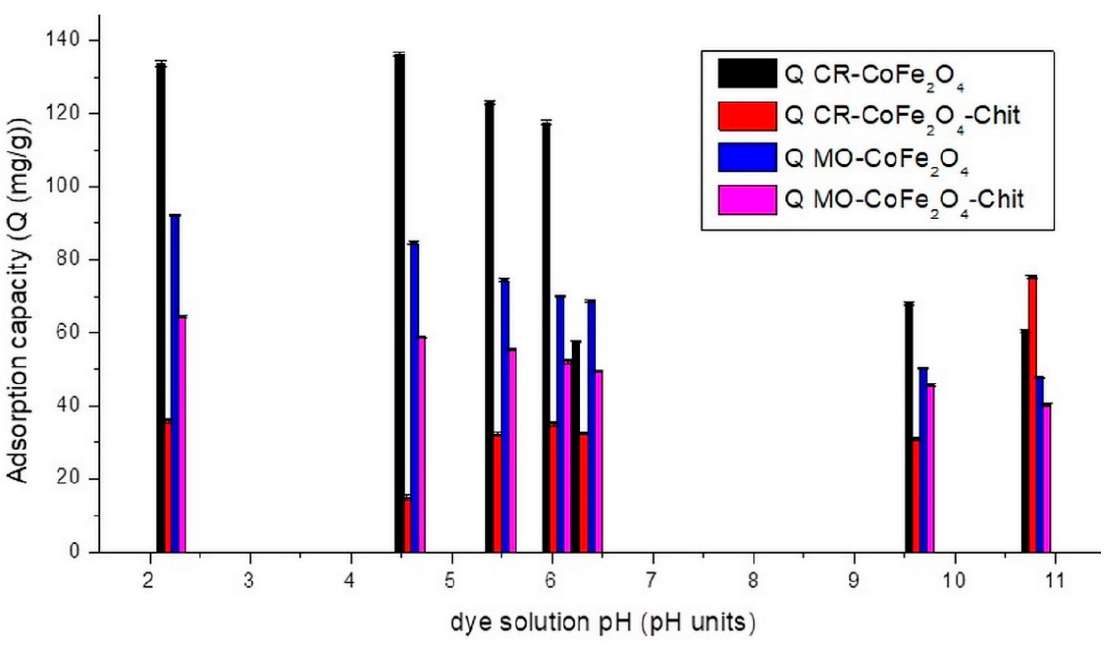
Figure 9. The variation of adsorption capacity versus the CR/MO solution’s pH (single system).